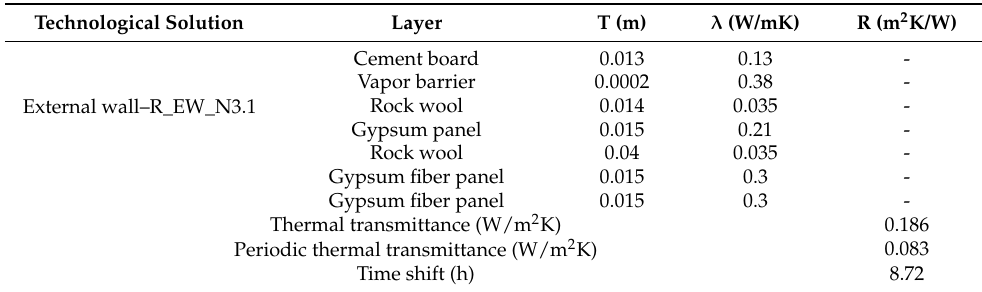
Table A25. Possible redevelopment measure for external wall with dry solution (wood fiber in- sulation) characterized by the half value of the thermal transmittance of the reference building (R_EW_N3.1).